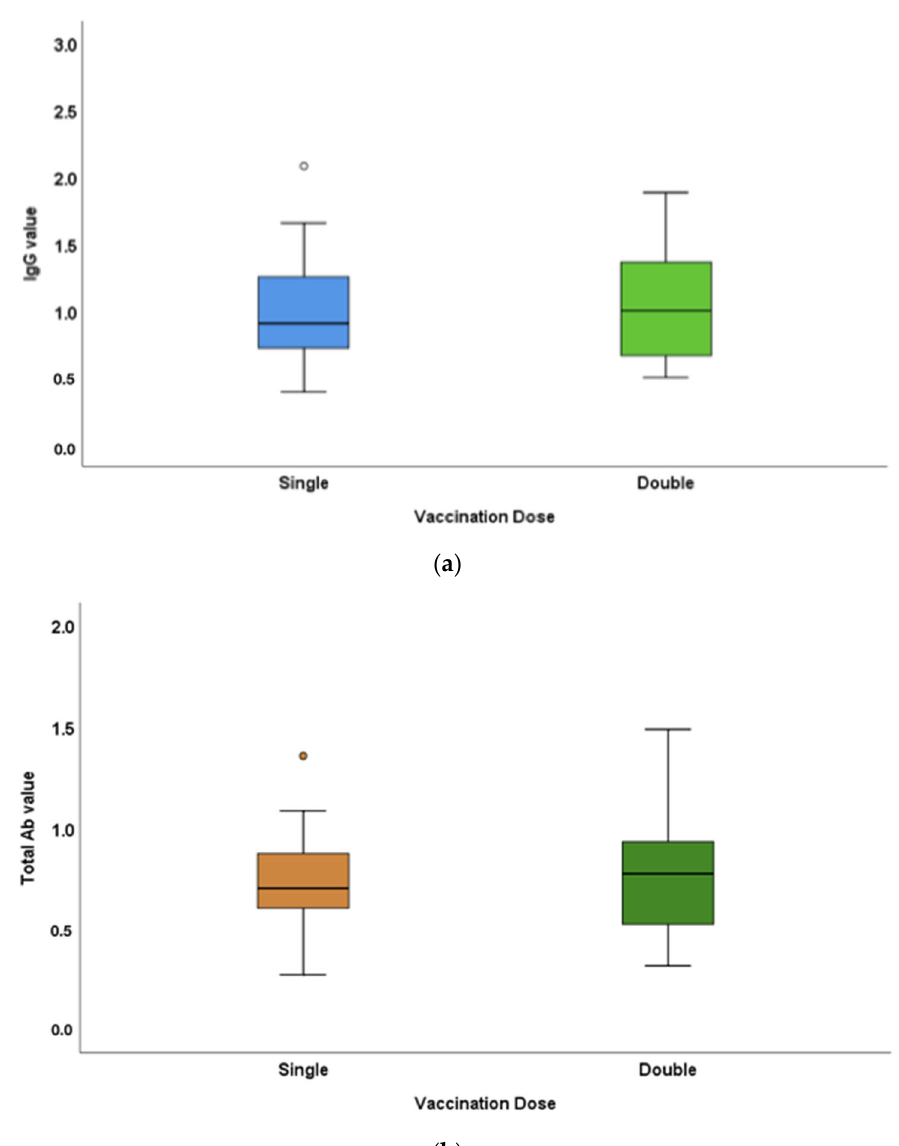
Figure 3. Mean IgG and Total antibody titre differences between single ‐ and double ‐ dose ‐ vaccinated participants in the study: ( a ) IgG titres in single ‐ and double ‐ dose ‐ vaccinated populations were 0.99 ± 0.37 and 1.06 ± 0.44 g, respectively. ( b ) Total antibody titres in single ‐ and double ‐ dose ‐ vaccinated populations in the study were 0.73 ± 0.22 and 0.76 ± 0.26 g, respectively. IgG and total antibody levels were greater in double ‐ dose ‐ vaccinated individuals compared to those of the single ‐ dose ‐ vaccinated population. Differences in the antibody titres between the single ‐ and double ‐ dose ‐ vac ‐ cinated population were not statistically significant ( p ‐ values = 0.75 and 0.65, respectively).